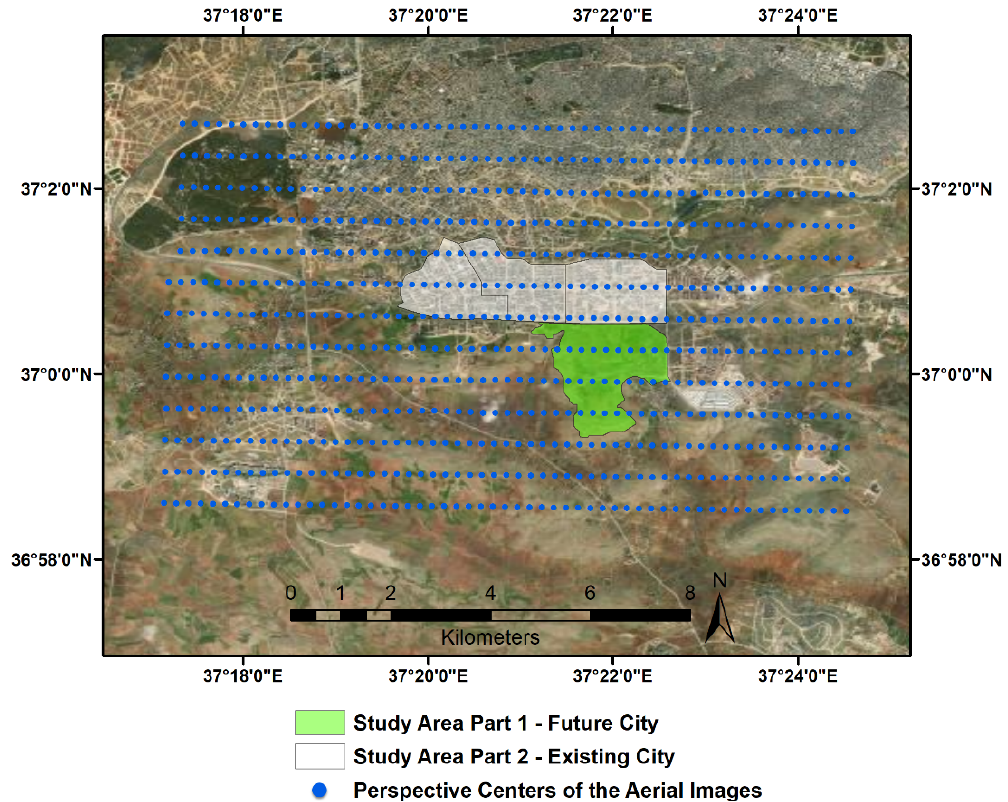
Figure 1. A general view of the study area in Sahinbey, Gaziantep with the boundaries of the reconstructed three-dimensional (3D) model of existing city parts (white) and the designed future city (green). The perspective center positions of the aerial photos used for the reconstruction are depicted with the blue points.